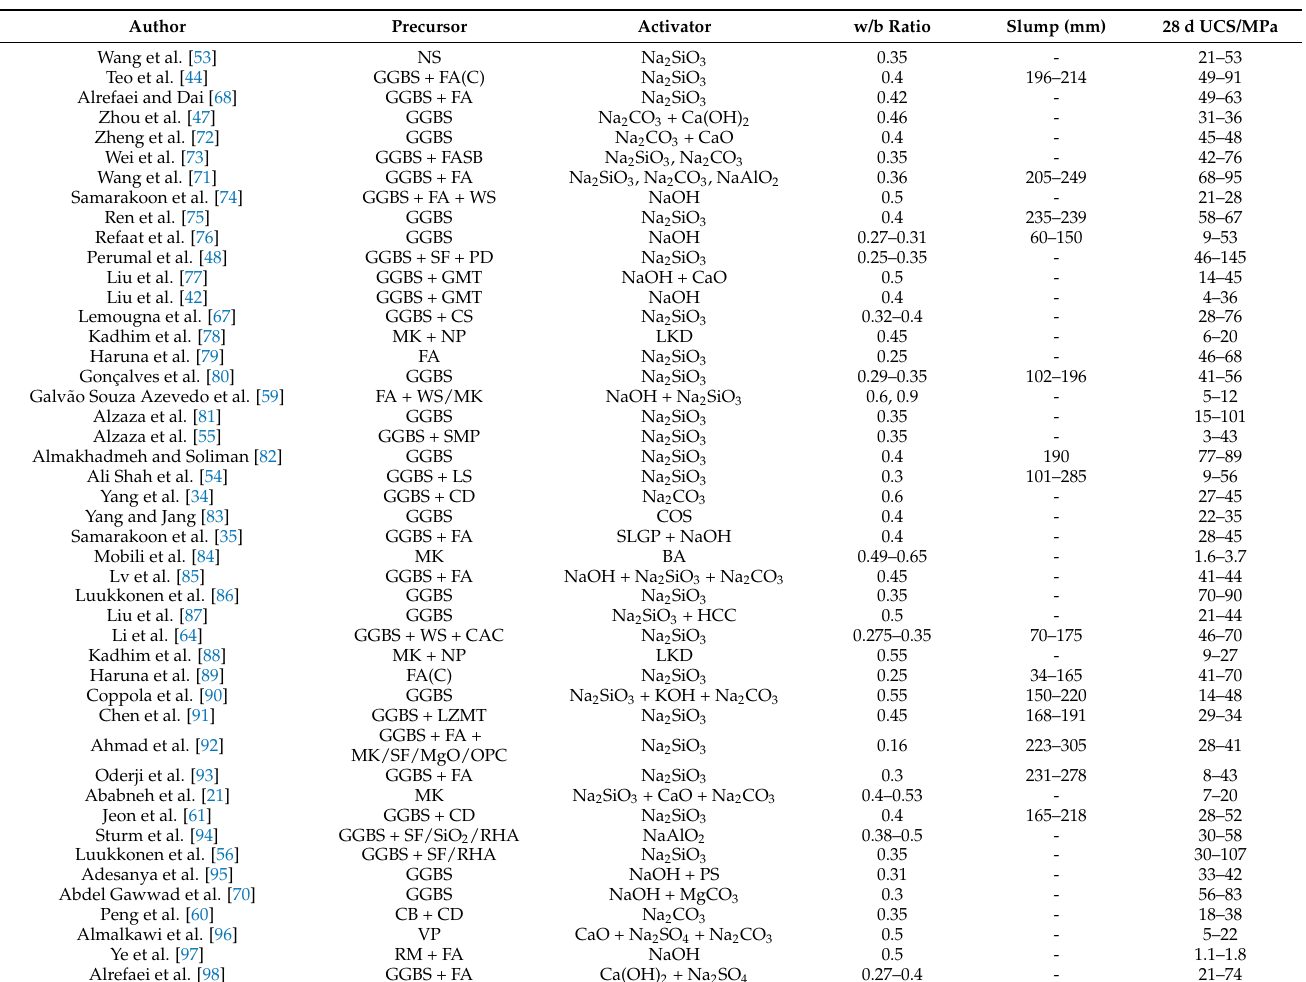
Table 1. Performance of one-part AAM with different precursors and